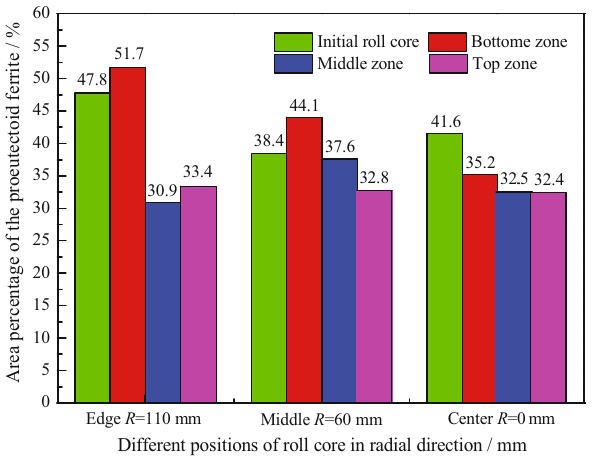
Figure 8: Temperature distribution of roll core surface in longitudinal